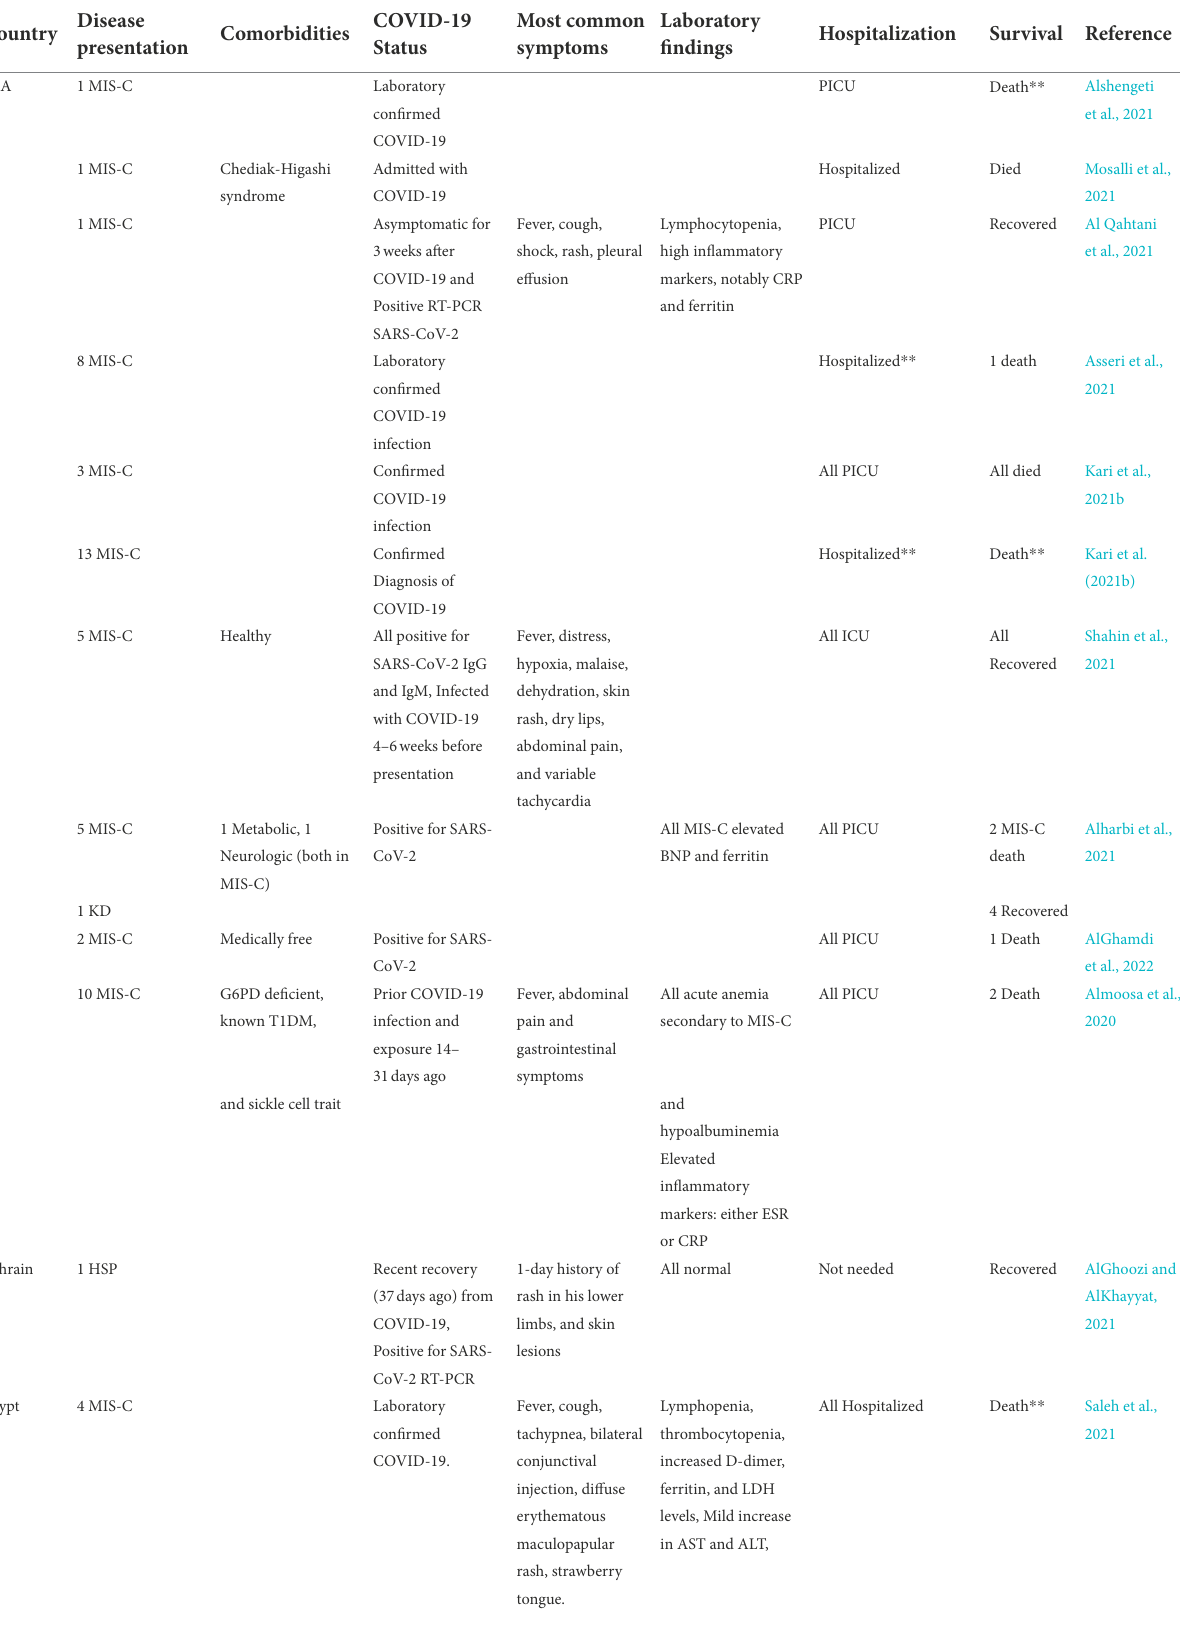
TABLE 2 Atypical presentations of COVID-19 in children in the Middle East. Disease Country